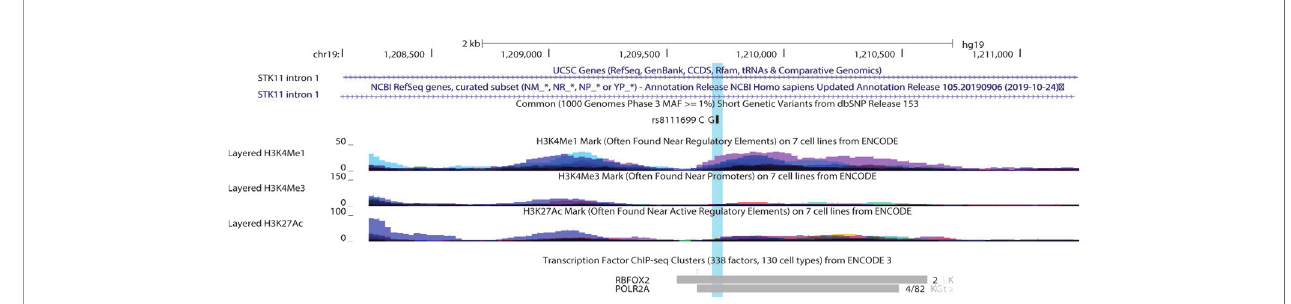
FIGURE 7 | UCSC Genome Brower (Human Feb 2009 (GRCh37/hg19 assembly) displaying rs8111699 (highlighted) and tracks representing histone marks and transcription factors in the fi rst intron of STK11 . For histone marks peak height is proportional to the signal amplitude with colors representing databases in seven different cell lines*. For transcription factor binding tracks, the length of the box indicates region of occupancy and the darkness is proportional to the signal strength observed in several cell lines. To the right there is the number of cell types contributing to the cluster or a fraction that corresponds the number of cell where the factor was detected out of all cell assayed. The letters represent the cell abbreviation L, HepG2; K, K562; a, adrenal gland; G, GM12878; t, tibial nerve. * 7 Cell lines for histone marks from ECODE: GM12878 (B-lymphocyte, lymphoblastoid), H1-hESC (embryonic stem cells), HSMM (skeletal muscle myoblasts), HUVEC (umbilical vein endothelial cells), K562 (erythroleukemic), NHEK (epidermal keratinocytes), NHLF (lung fi broblasts).